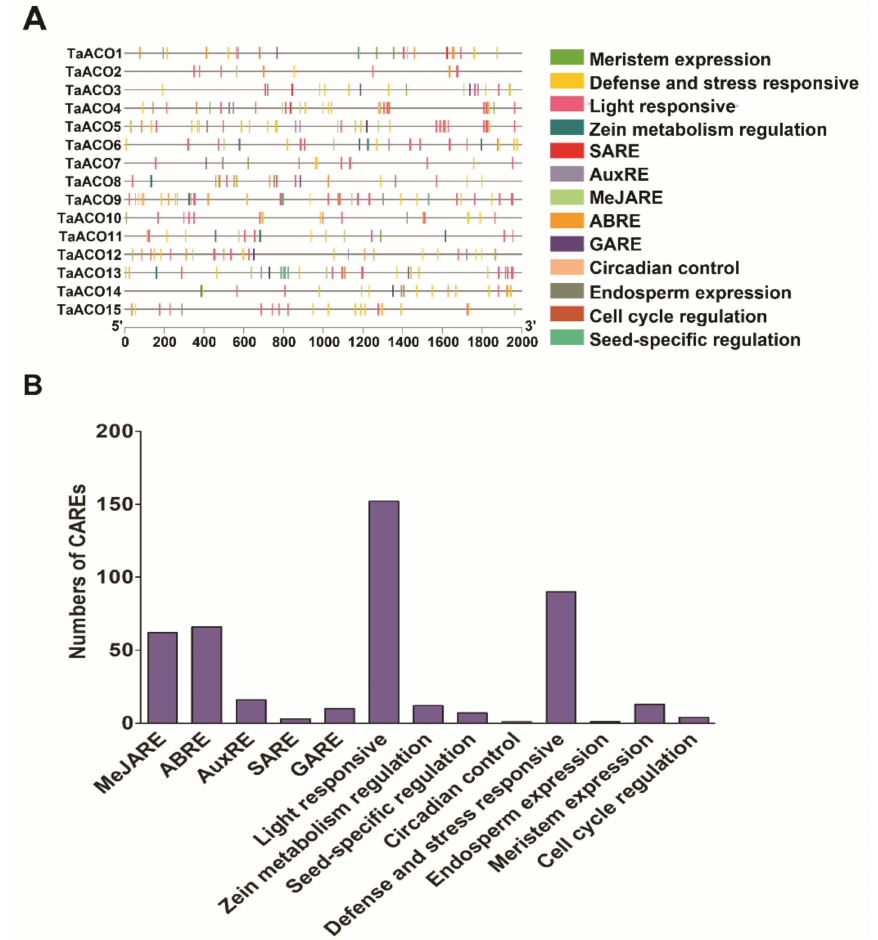
Figure 7. Cis-acting regulatory elements (CAREs) predicted in the TaACO promoters using the PlantCARE website. ( A ) The different colors represent the various CARE-related to phytohormone, defense and stress, growth, and development. ( B ) Most frequently predicted CAREs in the TaACO promoter